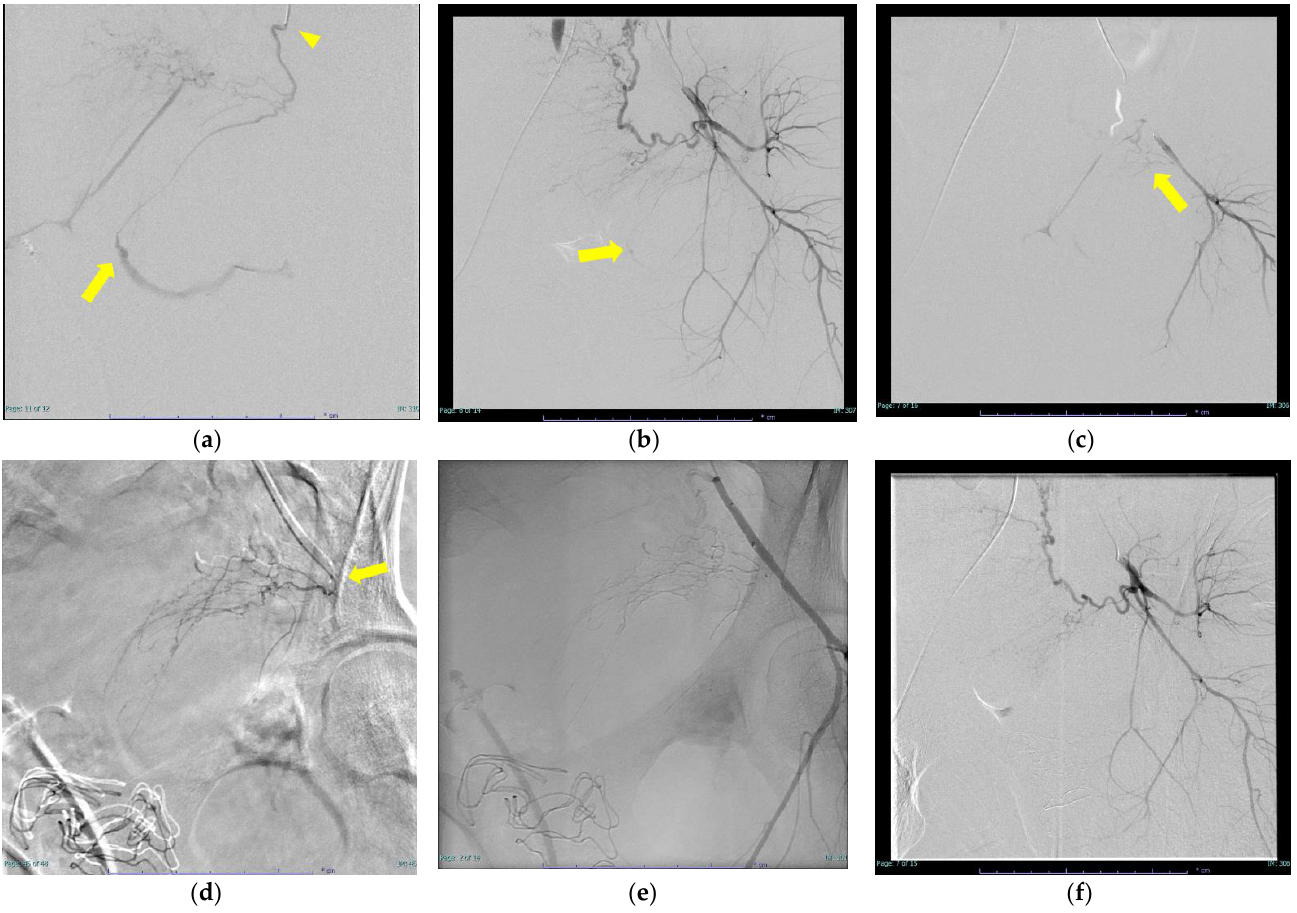
Figure 3. Collateral tract due to a proximal embolism (in Case 3). ( a ) Vaginal branch of uterine artery angiography. (Arrow) Extravasation is observed. (Arrowhead) The catheter could not be advanced any further, and embolization was performed with NBCA diluted solution (NBCA:lipiodol = 1:4). NBCA did not reach the bleeding point, resulting in a proximal embolism. ( b ) Post-embolization internal iliac artery angiography. (Arrow) Bleeding images are still observed via the collateral tract. ( c ) (Arrow) Bleeding remained from the small diameter collateral tract branching from the inferior gluteal artery. ( d ) (Arrow) The catheter could not be advanced to the vicinity of the bleeding point. ( e ) Since the blood vessels were very fine, embolization was performed using an NBCA diluted solution (NBCA:lipiodol = 1:12). ( f ) Left internal iliac artery angiography. Extravasation image has disappeared.